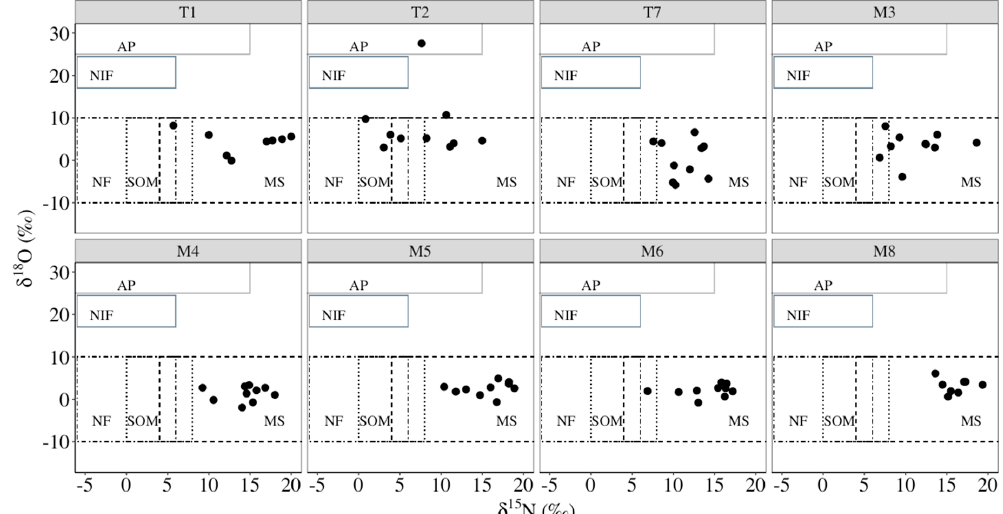
Figure 4. Dual δ 15 N-NO 3 and δ 18 O-NO 3 in the Yuntaishan River basin. Five areas show different nitrogen sources. The range of the δ 15 N-NO 3 and δ 18 O-NO 3 values are from Kendall et al. (2008) and Xue et al. (2009). NIF is NO 3 − in fertilizer, NF is NH 4+ in fertilizer and precipitation, SOM is nitrogen in soil organic matter, MS is manure sewage and AP is atmospheric precipitation.